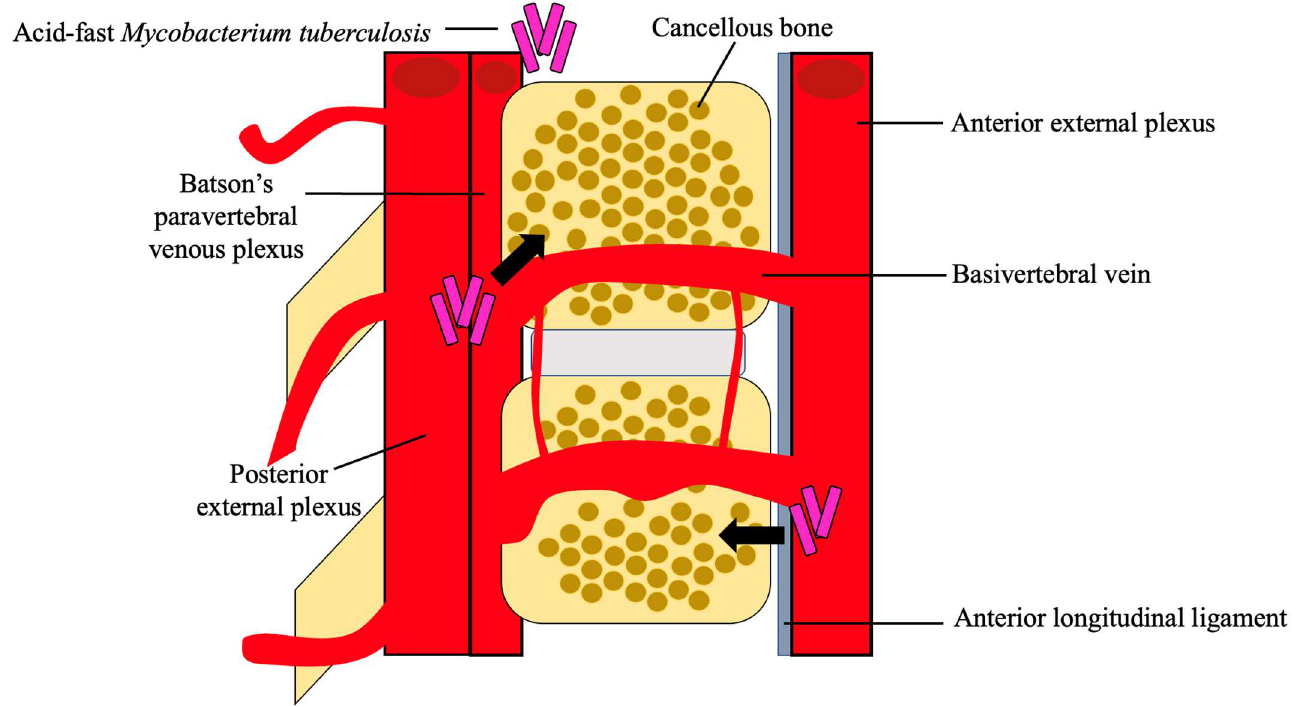
Figure 2. Hematogenous spread of M. tb . M. tb reaches the cancellous bone through the anterior and posterior external venous plexuses. A combination of the valveless Batson’s paravertebral venous plexus and cavity pressures spreads M. tb to the inferior anterior portion of the vertebra and ultimately to the anterior longitudinal ligament where it may disseminate to adjacent vertebra [4,5,18,21].